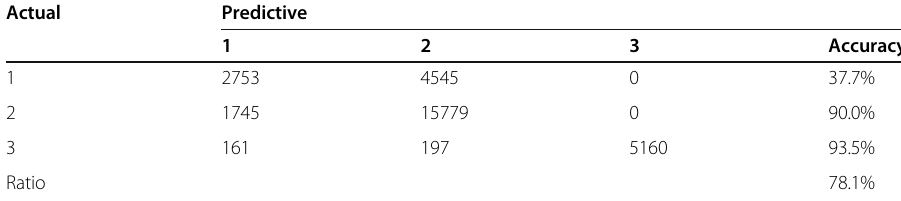
Table 4 Discriminant analysis of multiple logistic main effect regression